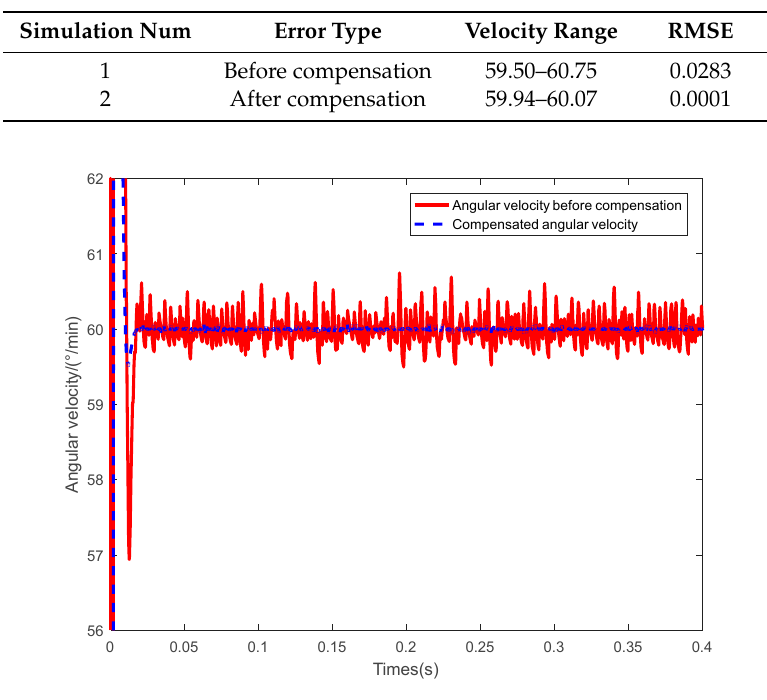
Figure 11. Angular velocity of